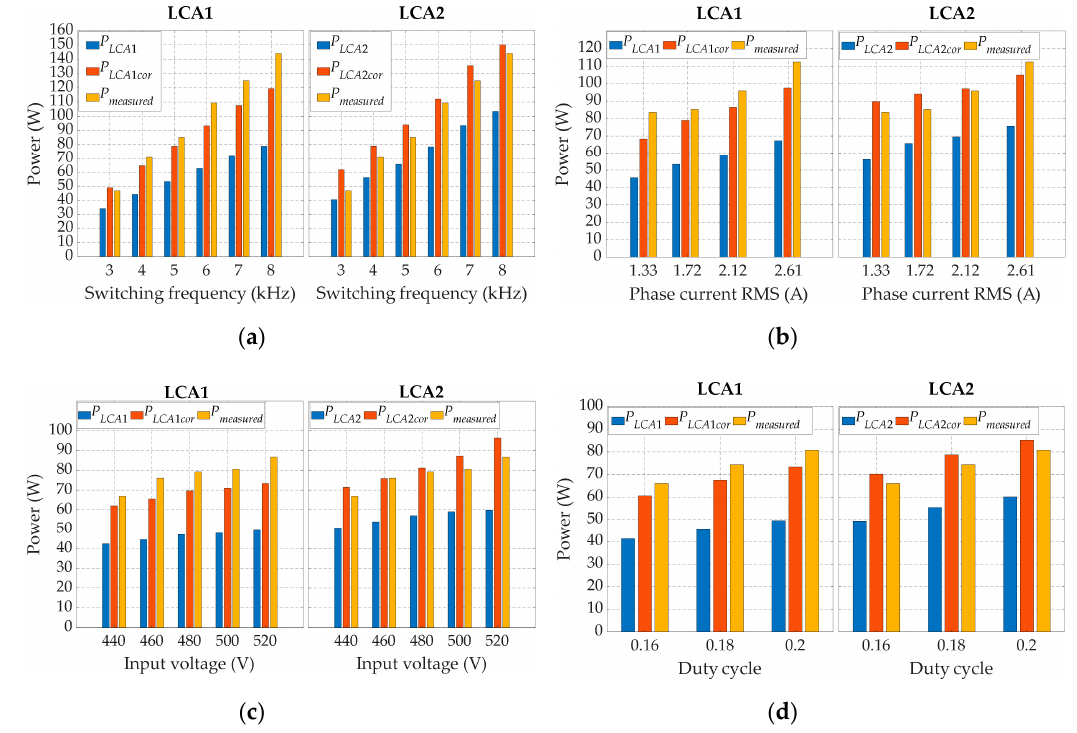
Figure 8. Measured and calculated semiconductor losses with respect to: switching frequency ( a ), RMS phase current ( b ), input voltage ( c ), and duty cycle ( d ). Table 3. Absolute and relative errors with respect to the measured semiconductor losses of the proposed